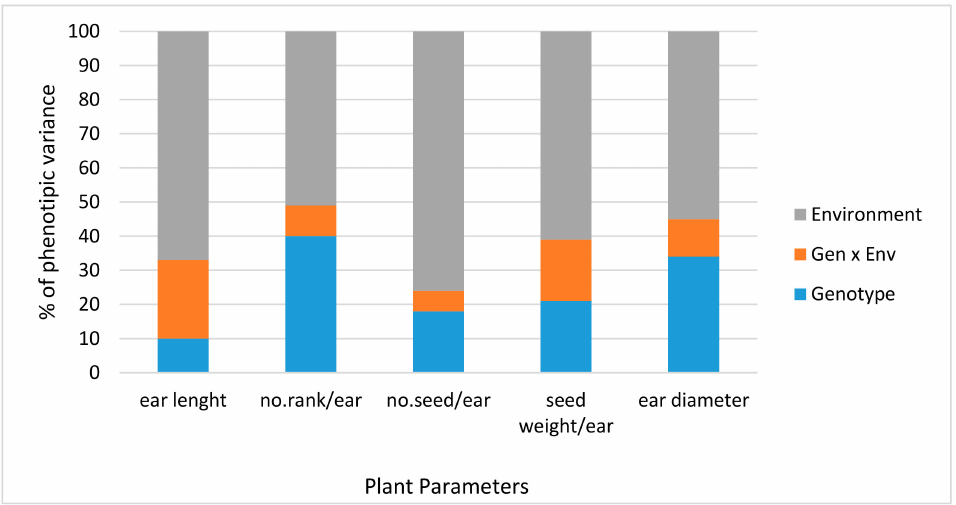
Figure 2. Partition of the phenotypic variance of the di ff erent plant